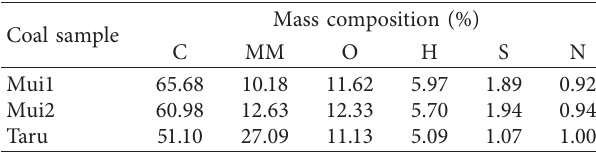
Table 2: Ultimate analysis results for Taru and Mui basins coals. Mass composition Coal sample